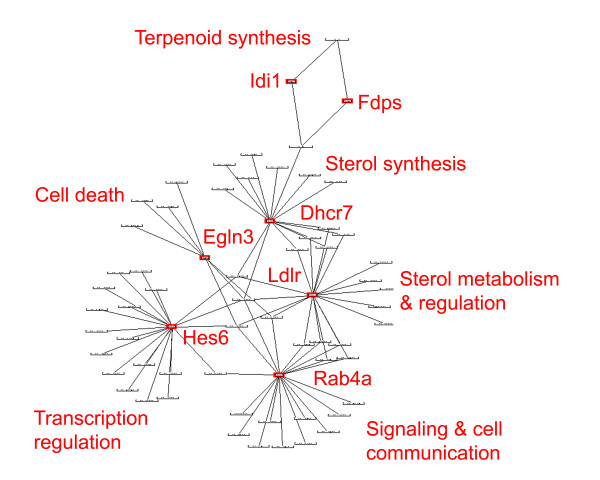
Manipulation and filtering of GTAN to gain insights of gene-term relationships. Highlighted the selected genes in Fig. 13 including Egln3, Hes6, Ldlr, Rab4a, Dhcr7, Fdps, and Idi1, and then retrieved their neighbors (terms) to re-build the graph by SVG. Terms are labeled as summarized descriptions due to close relevancy.